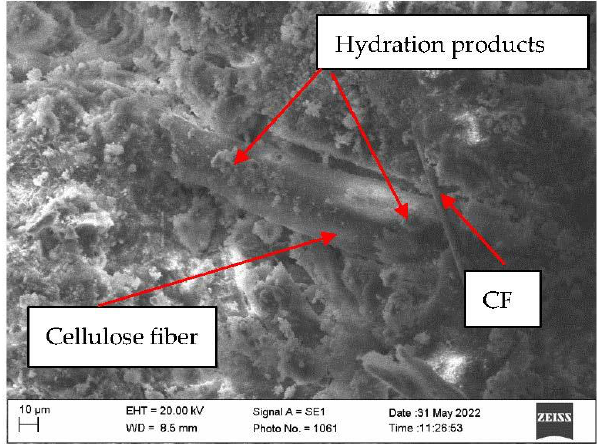
Figure 8. Microstructure of the sample